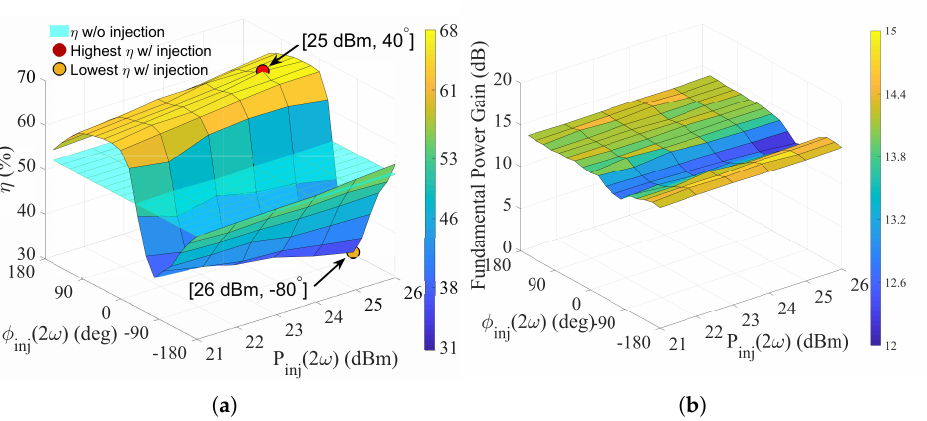
Figure 8. Measured ( a ) drain efficiency and ( b ) fundamental power gain with input CW second- harmonic injection at 4